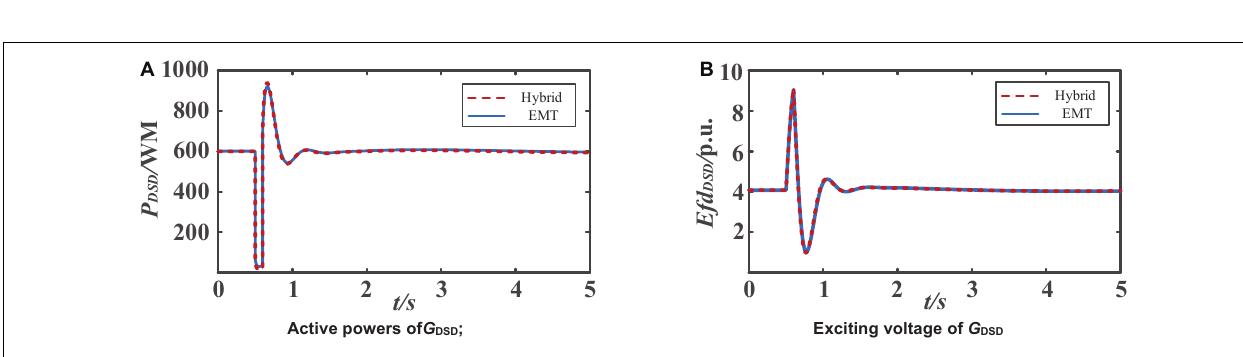
FIGURE 9 | Dynamic characteristics of generators in the EMT simulation; (A) Active powers of G DSD ; (B) Exciting voltage of G DSD .